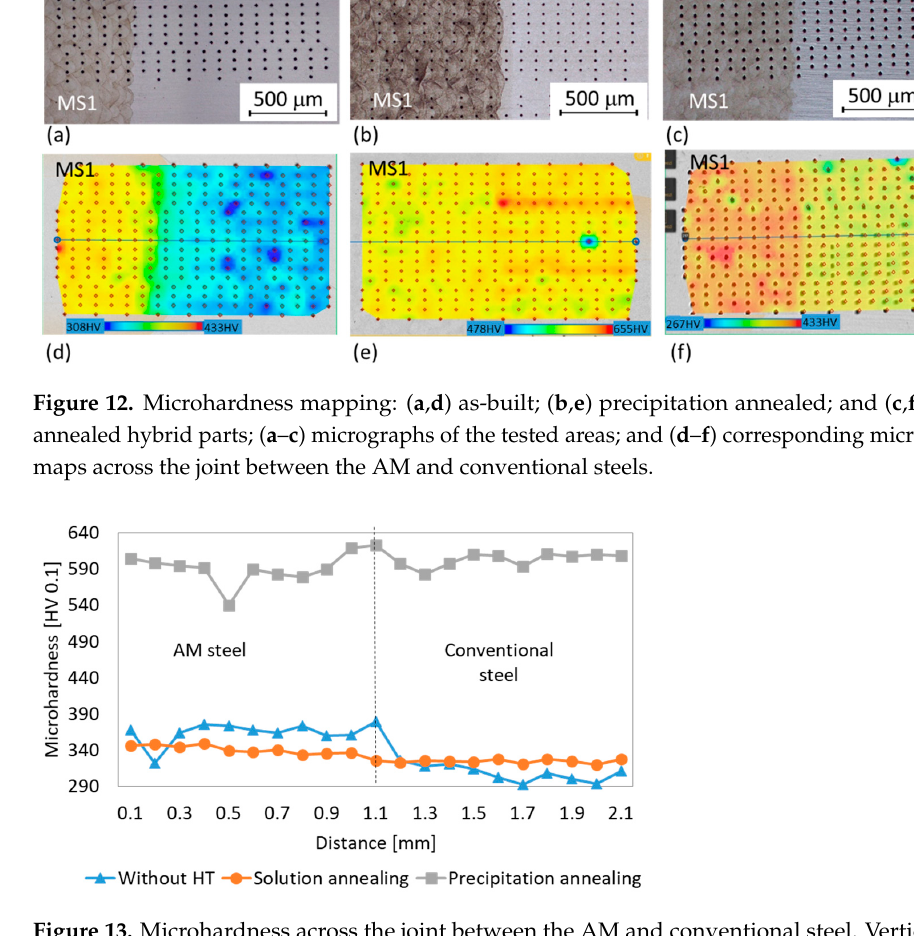
Figure 13. Microhardness across the joint between the AM and conventional steel. Vertical dotted line marks the interface. line marks the